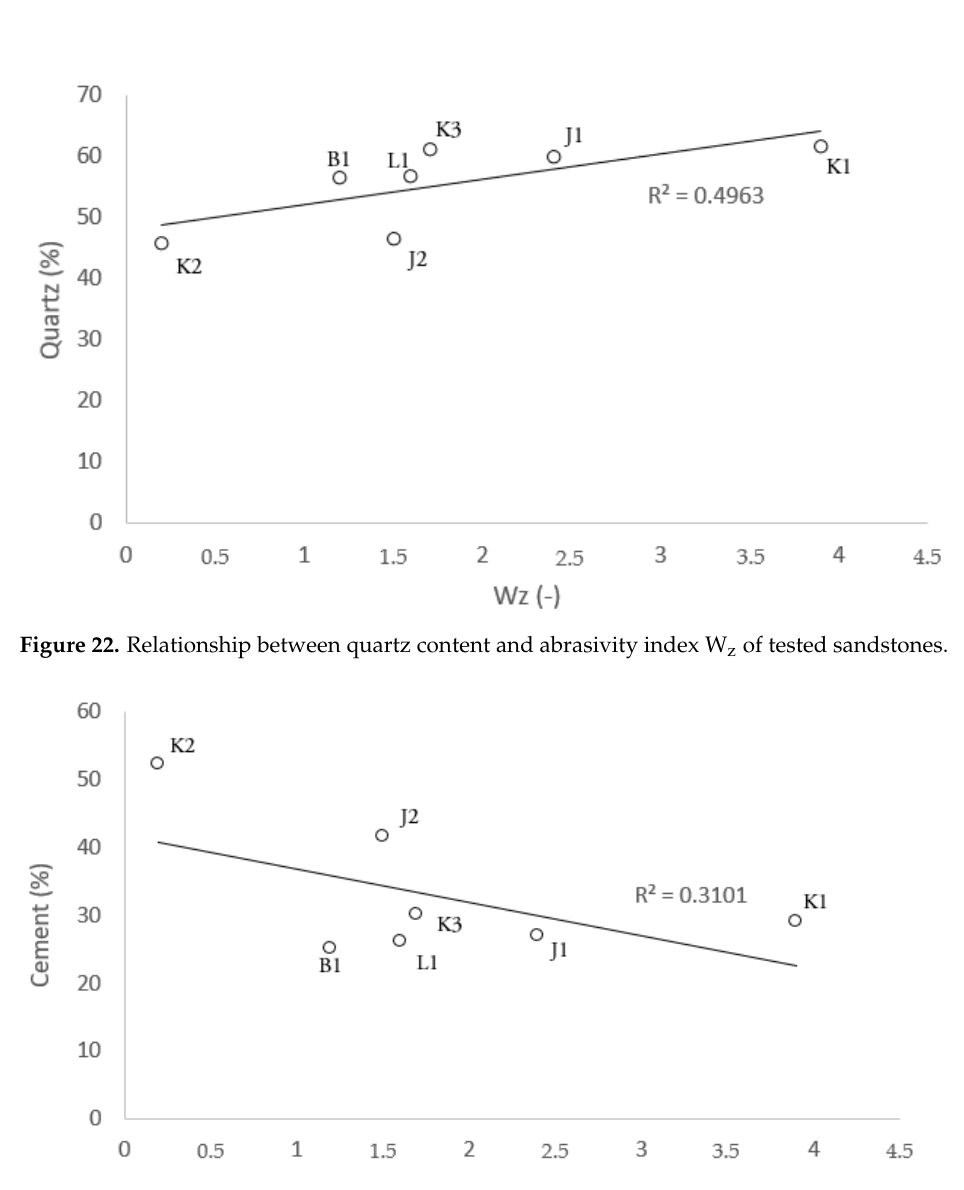
16 of 21 Figure 21. Graph illustrating the lack of relationship between USC and abrasivity index W z . 4.3. Influence of Petrographic Properties on Abrasive Properties of Tested Sandstones